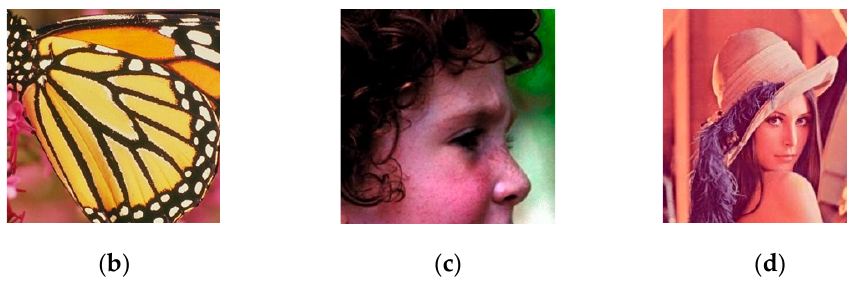
Figure 3. Natural images for generating synthetic LR images. ( a ) Baby; ( b ) Butterfly; ( c ) Head; ( d ) Lena.